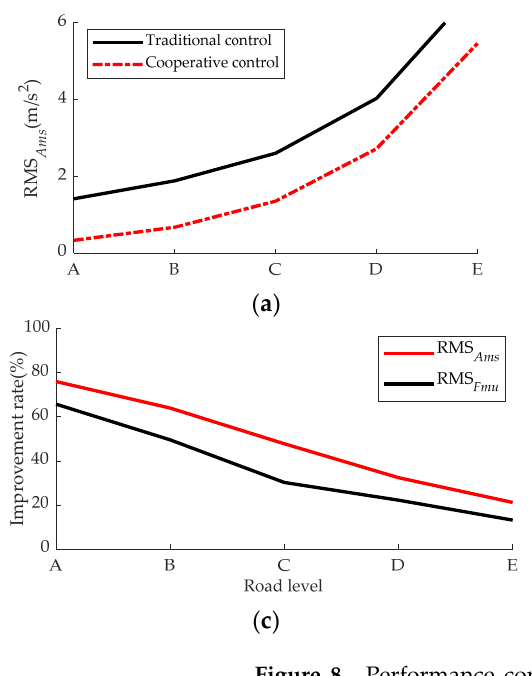
( a ) Comparison of RMS Ams between traditional control and cooperative control. ( b ) Comparison of